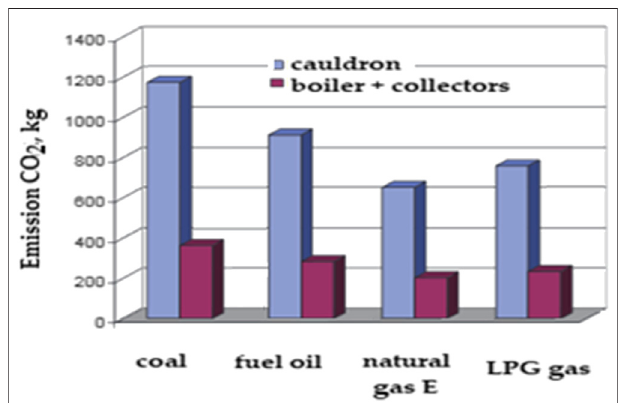
FIGURE6| Reductionofcarbon dioxide emissions asaresultoftheuse of solar collectors for the preparation of domestic hot water. Source: own